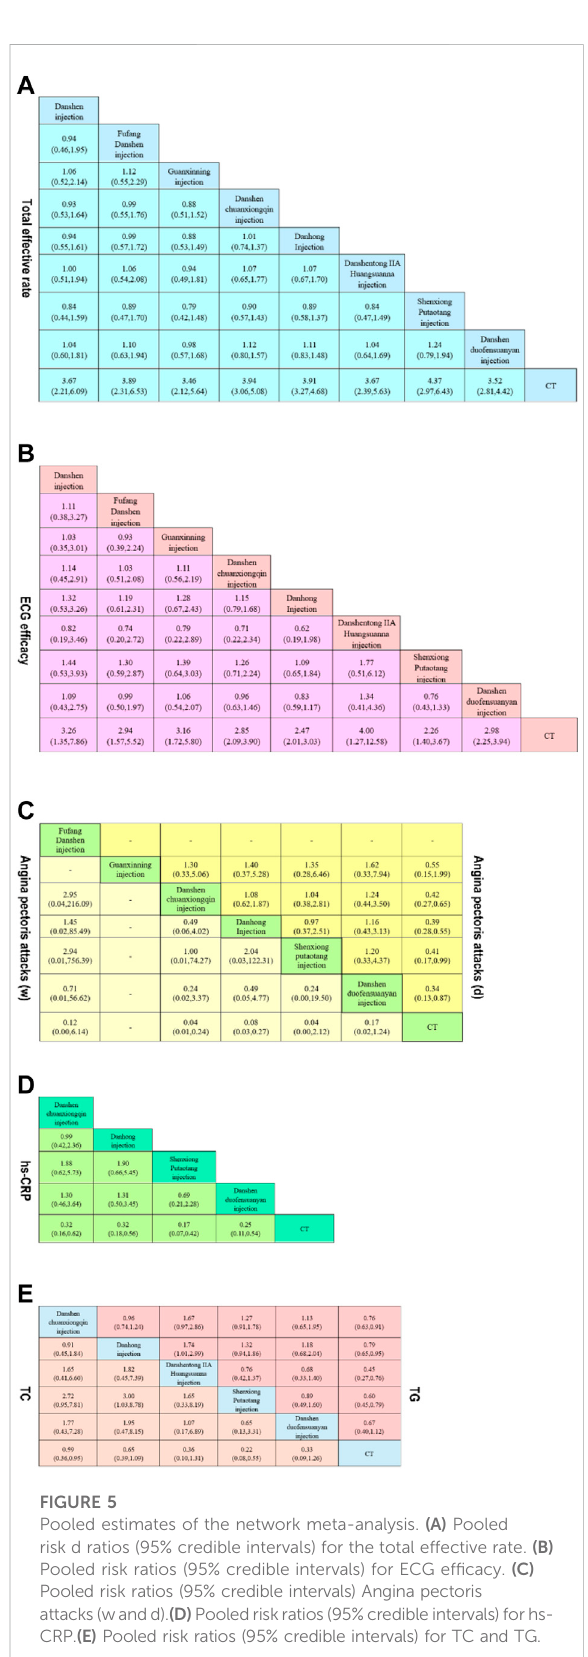
FIGURE 5 Pooled estimates of the network meta-analysis. (A) Pooled risk d ratios (95% credible intervals) for the total effective rate. (B) Pooled risk ratios (95% credible intervals) for ECG ef fi cacy. (C) Pooled risk ratios (95% credible intervals) Angina pectoris attacks(wandd). (D) Pooledriskratios(95%credibleintervals)forhs- CRP. (E) Pooled risk ratios (95% credible intervals) for TC and